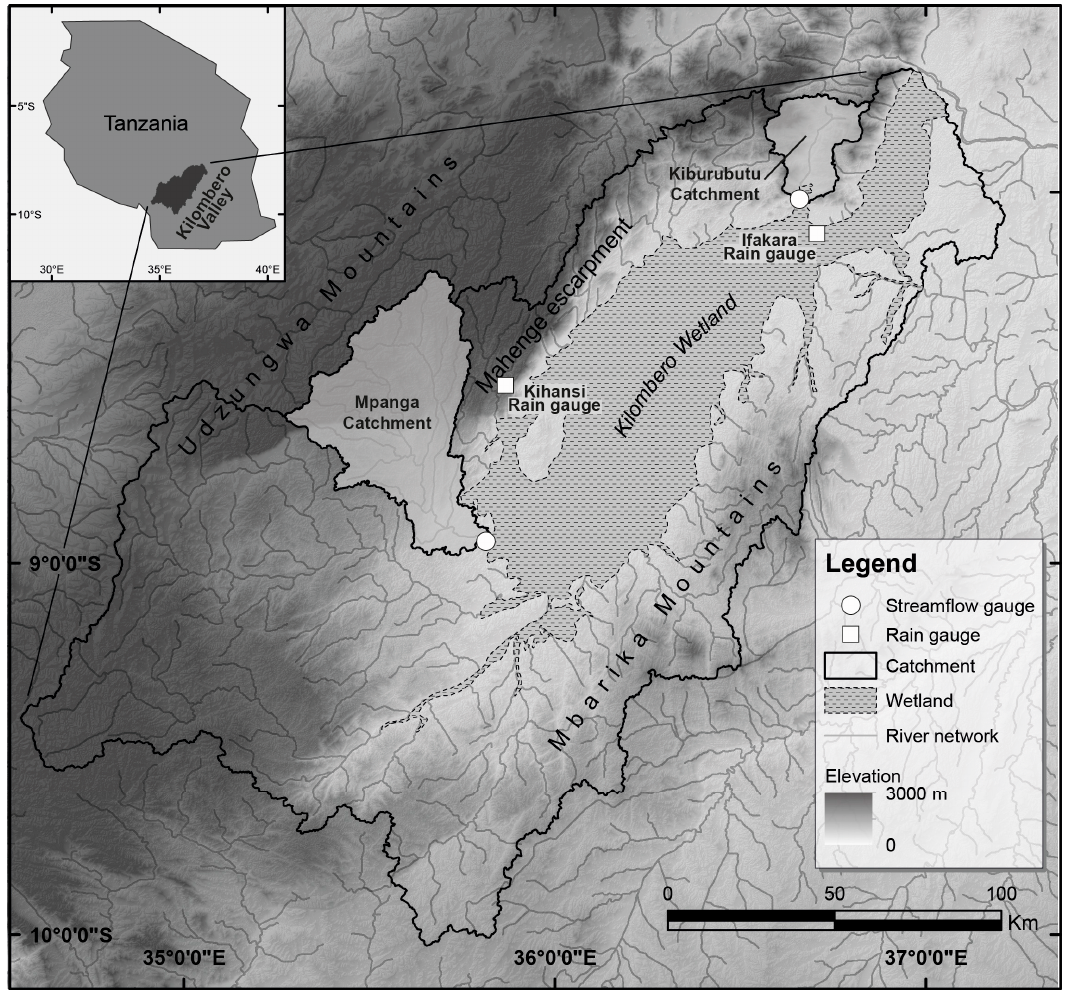
Figure 1. Topography and location of KV (KV) drainage basin in Tanzania. The location of Mpanga Catchment (MC) and Kiburubutu Catchment (KC) (solid black lines) are shown together with the river network, the wetland (cross hatch with dotted outline), streamflow gauges (white circle) and rain gauges used for bias correction (white squares). Topography is based on Shuttle Radar Topography Mission (SRTM) data [35].